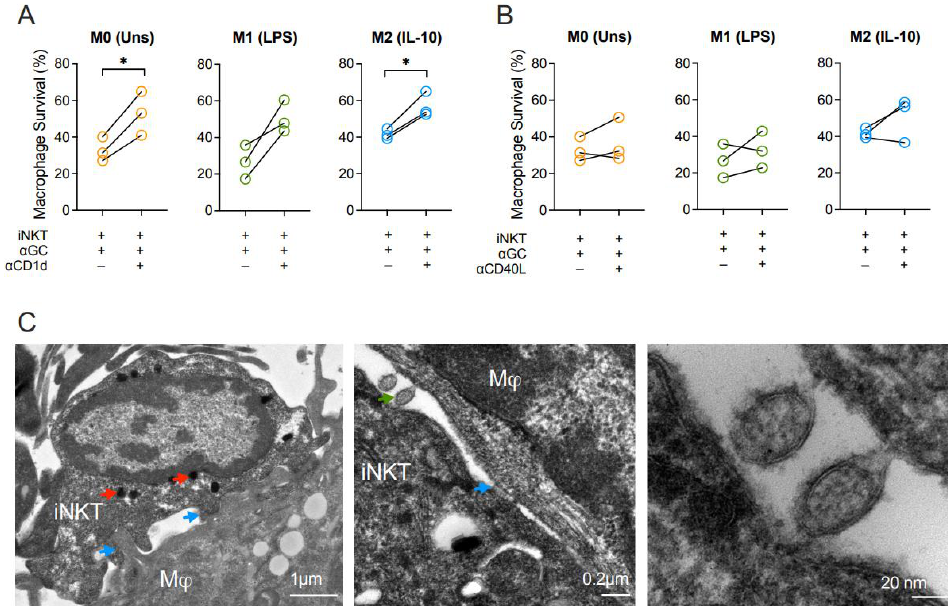
Figure 4. Cytotoxicity of iNKT cells towards macrophages is mediated by CD1d. Survival of M0 (Unstimulated), M1- (LPS-stimulated) and M2-like (IL-10-stimulated) macrophages co-cultured with iNKT cells and α -GalCer (60 nM) for 18 h in the presence or absence of ( A ) anti-CD1d or ( B ) anti-CD40L blocking antibodies. ( C ) Transmission electron microscopy of synapse between an iNKT cell and a macrophage after 18 h of co-culture. Blue arrow: synapse, red arrow: charged vesicles, green arrow: vesicular exchange. Representative pictures of 1 subject, taken with a 15,000× (left), 40,000× (middle) and 300,000× (right) magnification, using a CCD digital camera Orious 1100 W. Scale bar: 1 μ m (left), 0.2 μ m (middle), 20 nm (right). Data are representative of ( A , B ) 3 independent experiments. * p < 0.05. Paired t -test.